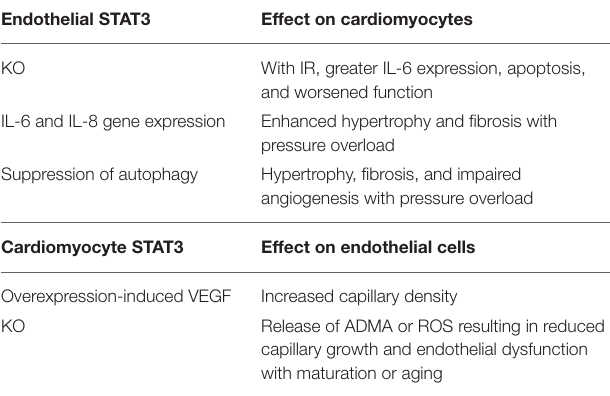
TABLE 1 | Contribution of cell-specific STAT3 to endothelial-cardiomyocyte crosstalk. Endothelial